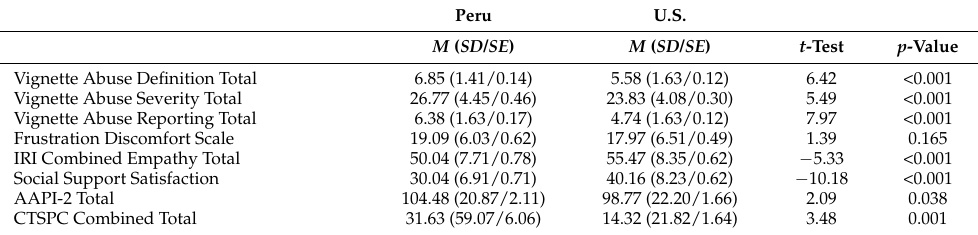
Table 1. Means and standard deviations by group.